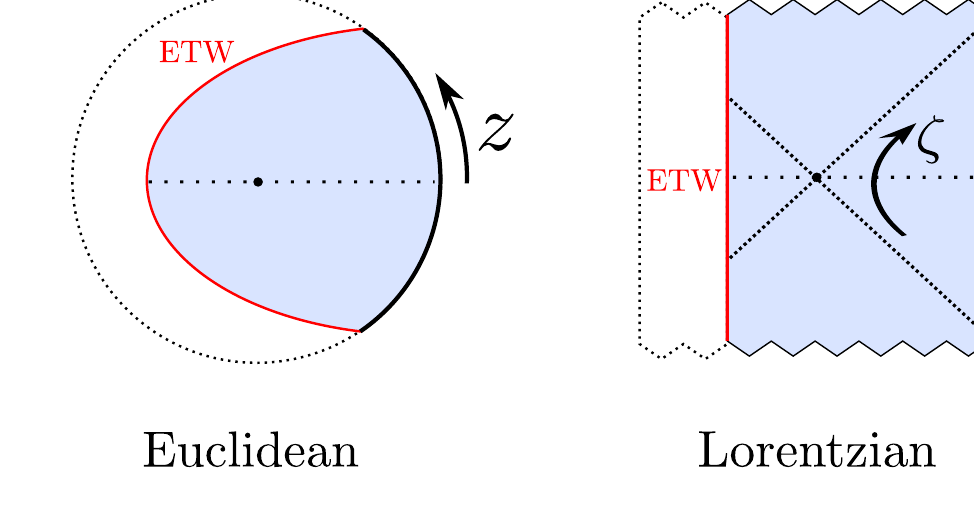
Figure 1 . An approach to holographic cosmology proposed in [8]. We begin on the left with a Euclidean BCFT path integral (bold black line), with some choice of boundary condition imposed in the past and future Euclidean time. The transverse directions suppressed in this figure could be taken to have S d or R d symmetry, so that the Euclidean CFT path integral is on a cylinder or a strip respectively. Cutting open this path integral at the moment of time symmetry, we obtain some state | Ψ i of the holographic CFT. In the bulk, we have a Euclidean asymptotically AdS spacetime (blue) terminating on an ETW brane (red). We may then analytically continue to Lorentzian time to obtain the leading geometry encoding the evolution of | Ψ i , shown on the right. The ETW brane stays behind the horizon of an AdS black hole; it is a “big bang/big crunch” cosmology (with spherical or flat spatial sections). The construction is time-symmetric throughout, with the moment of time symmetry illustrated as a dotted line. Here, z indicates the Euclidean coordinate analytically continued to the Lorentzian time ζ